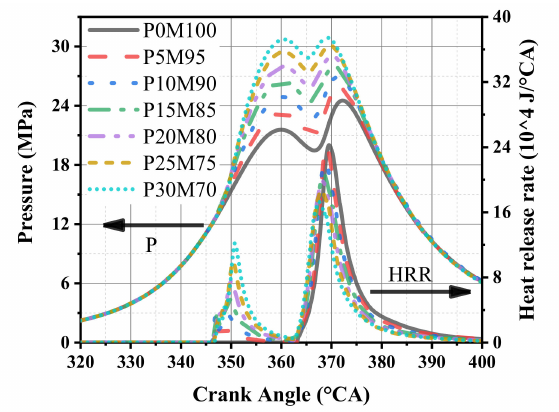
Figure 8. Impact of different pilot injection mass ratios on the in-cylinder pressure curves and heat release rate curves.